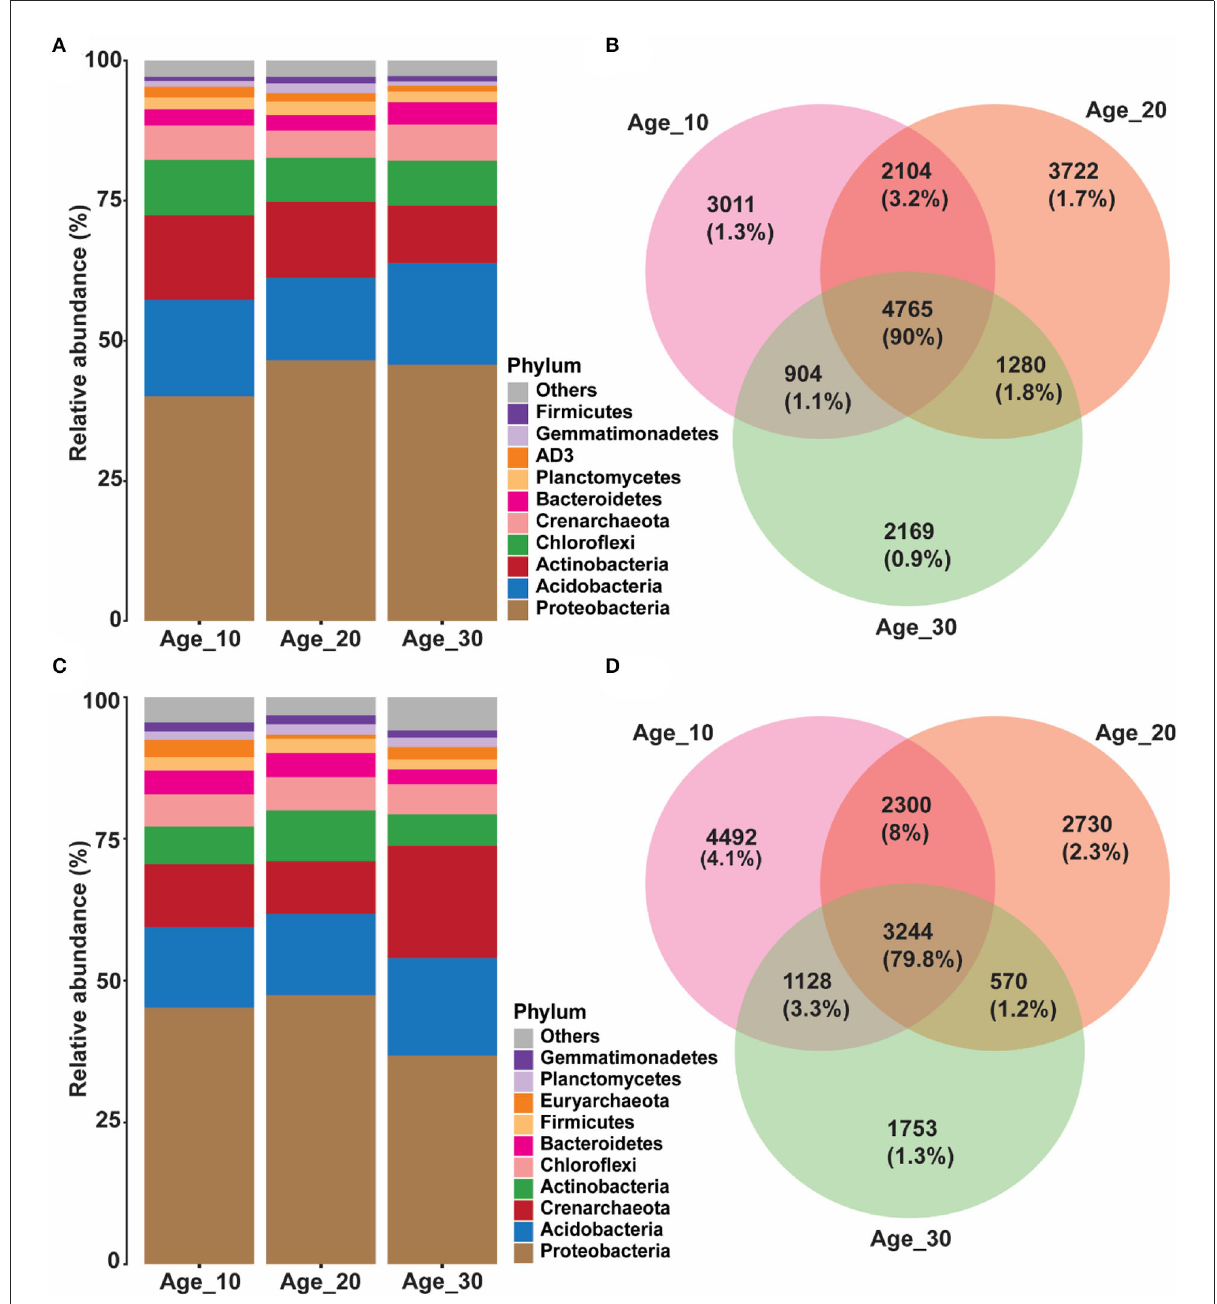
FIGURE2 Variations in relative abundance of soil bacterial community under different tree ages. Changes in relative abundance and comparison of bacterial community were observed under different tree ages; (A,B) red soil; and (C,D) paddy soil. Relative abundance has been shown of top 10 bacterial community at phylum level. The different lowercase letters indicate the significant differences ( p < 0.05) among different pomelo trees age groups of Age_10 (10 years old), Age_20 (20 years old), and Age_30 (30 years